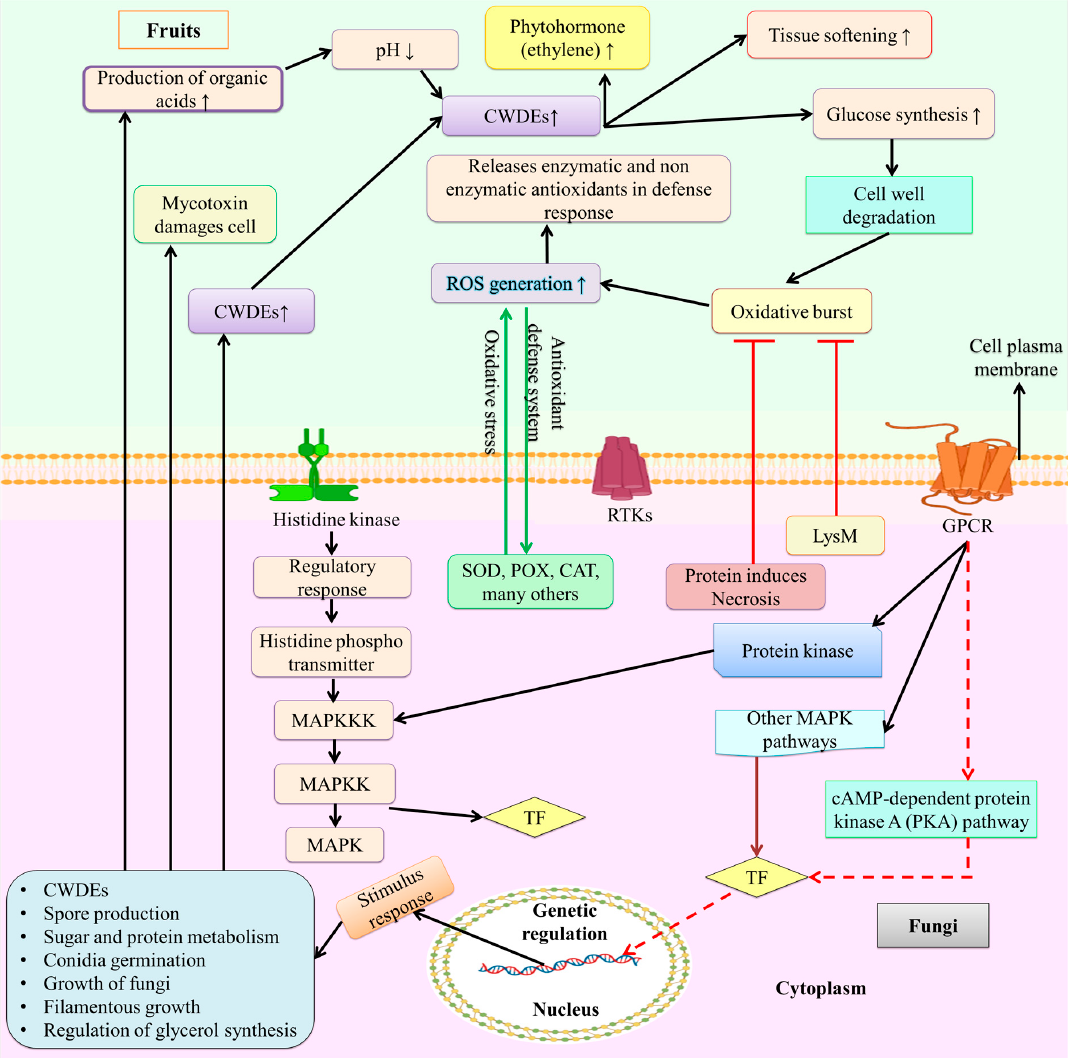
Figure 2. Fungal infection and signaling mechanism of fruit. On the surface of these spores, several signaling pathways are linked by proteins such as multiprotein complexes, signal transduction systems, receptor tyrosine kinases (RTKs), and G protein–coupled receptors (GPCRs), which are employed to sense environmental and host fruit stimuli. The primary signaling pathways involved in fruit fungal infection include MAPK, cAMP, and protein kinases that causes the activation of TF. These TFs trigger several cell signaling pathways. Similar to fruits cell the toxins produce by these pathway causes oxidative burst by producing ROS, activation on CWHEs, production of organic acid, volatile acid compound, and increases the synthesis of glucose that leads to tissue softening and damages fruit. Figure created with BioRender.com (https://app.biorender.com/biorender ‒ tem- plates)—accessed on 25 November 2022.